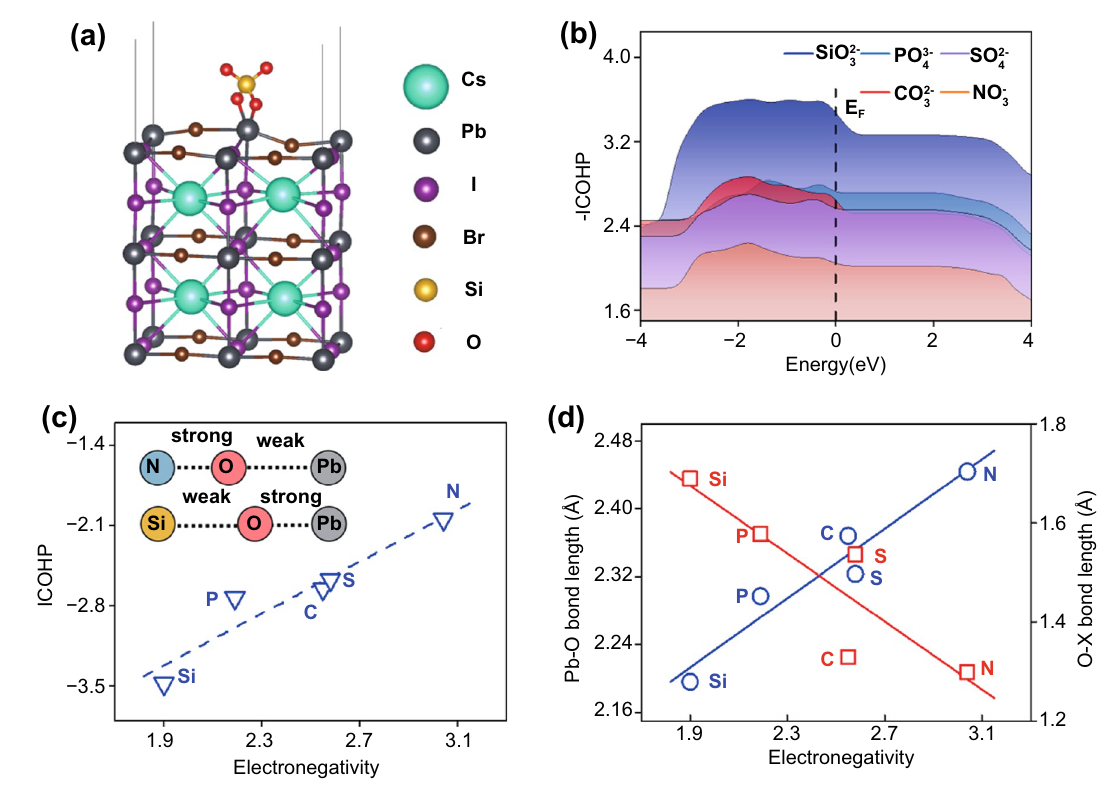
Fig. 1 a Optimized structure of CsPbI 2 Br (001) surface with SiO 32− adsorbed, where two O atoms in SiO 32− bind with Pb site. b Integrated crystal orbital Hamilton population (ICOHP) between Pb site and O atom in the oxyacid anions. More negative ICOHP means the stronger bond strength of Pb–O bond. c Relationship for ICOHP of the Pb–O bond on CsPbI 2 Br (001) surface with different oxyacid anions adsorbed as a function of electronegativity of central element X (X = N, S, C, P, Si). d Relationships of the bond lengths of the X–O (X = N, S, C, P, Si) and Pb–O bonds on CsPbI 2 Br (001) surface with different oxyacid anions as function of electronegativity of central element X. There is a trade-off between the lengths of X–O and Pb–O bonds in terms of the electronegativity of central